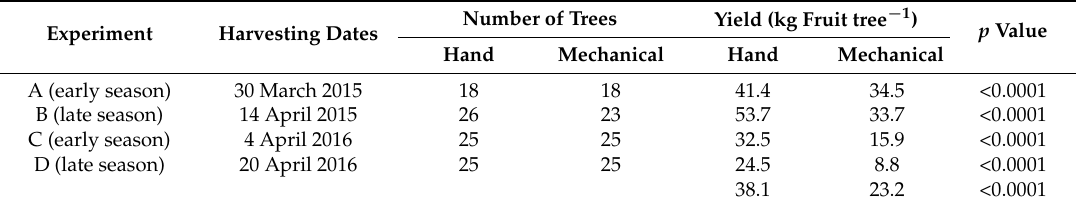
Table 4. Statistical variation of sweet orange “Valencia” tree yields under different harvesting methods at early and late harvesting seasons at Felda site in the southwest of Florida during 2015 and